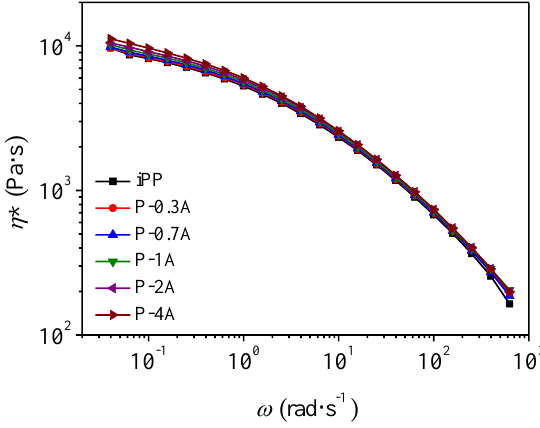
Figure 2. Storage modulus ( G ’) and complex viscosity ( η * ) with respect to angular frequency ( ω ) for pure iPP and ABS.